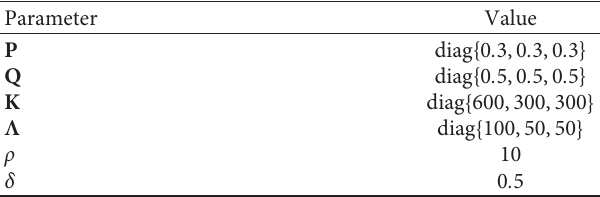
Table 2: Control gains of the utilized